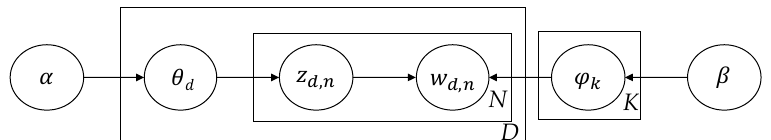
Figure 3. LDA graphic model. Source: adapted from [75].